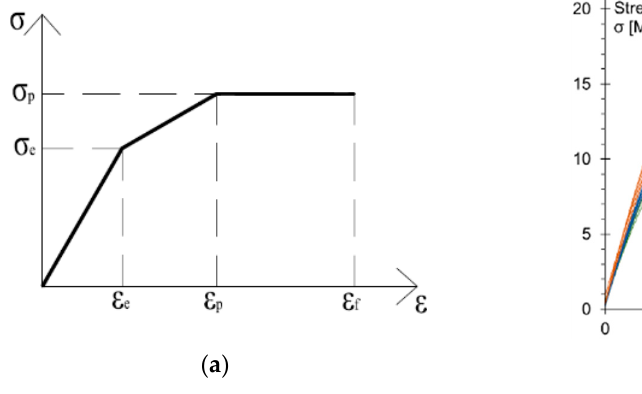
Figure 2. Tensile test: ( a ) simplified model for elastic-plastic material; ( b ) the stress-strain relationship obtained for three test speeds. Table 2. Tensile properties of the adhesive.